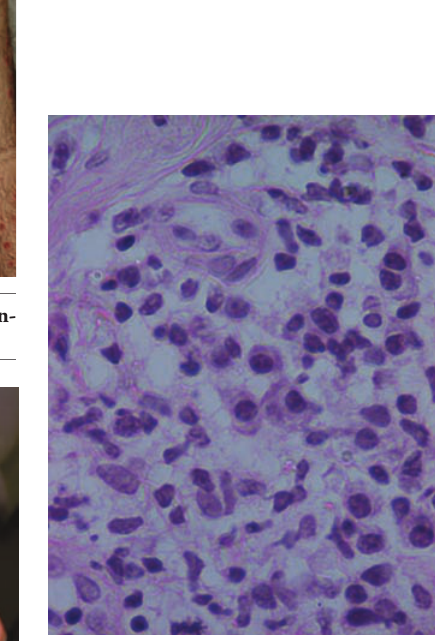
Figure 4. Multiple papules and nodules on the right sole.